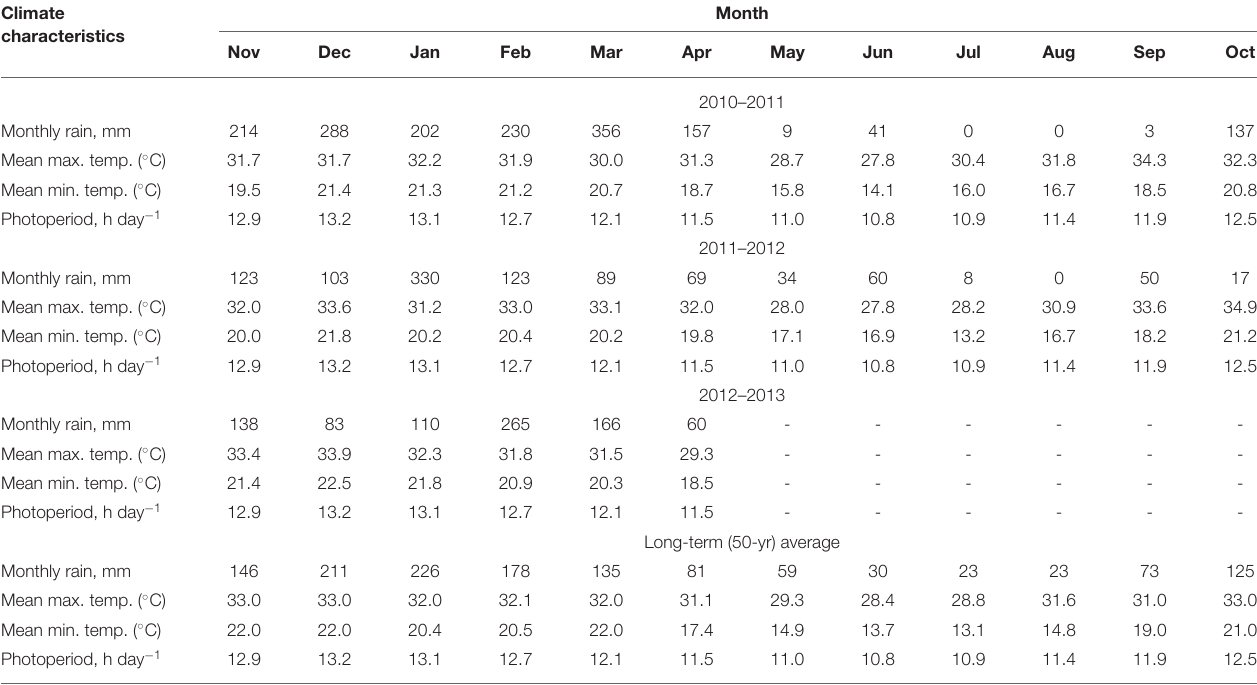
TABLE 1 | Rainfall, maximum and minimum temperatures, and photoperiod at Selvíria, Mato Grosso do Sul State, Brazil, during the study period. Climate